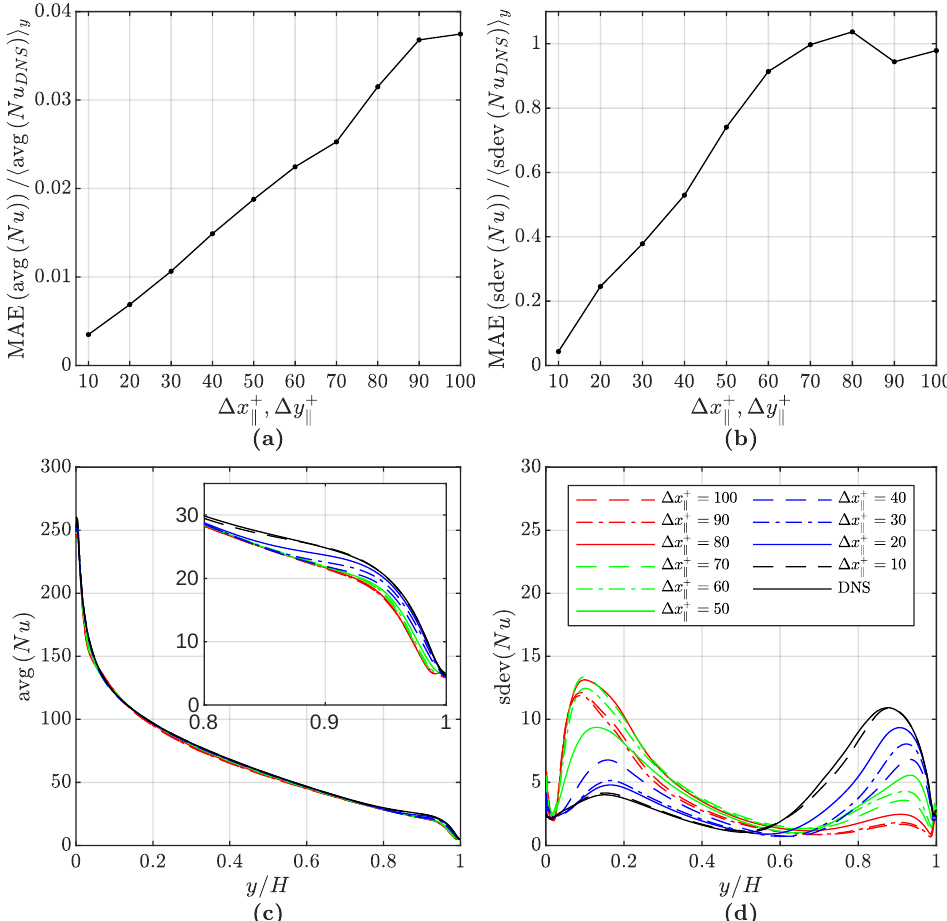
Figure 6. Mesh convergence study: ( a ) relative Mean Average Error (MAE) of the Nu number, ( b ) relative MAE of the standard deviation of the Nu number, ( c ) local Nu number profile on the vertical walls, and ( d ) local standard deviation profile of the local Nu